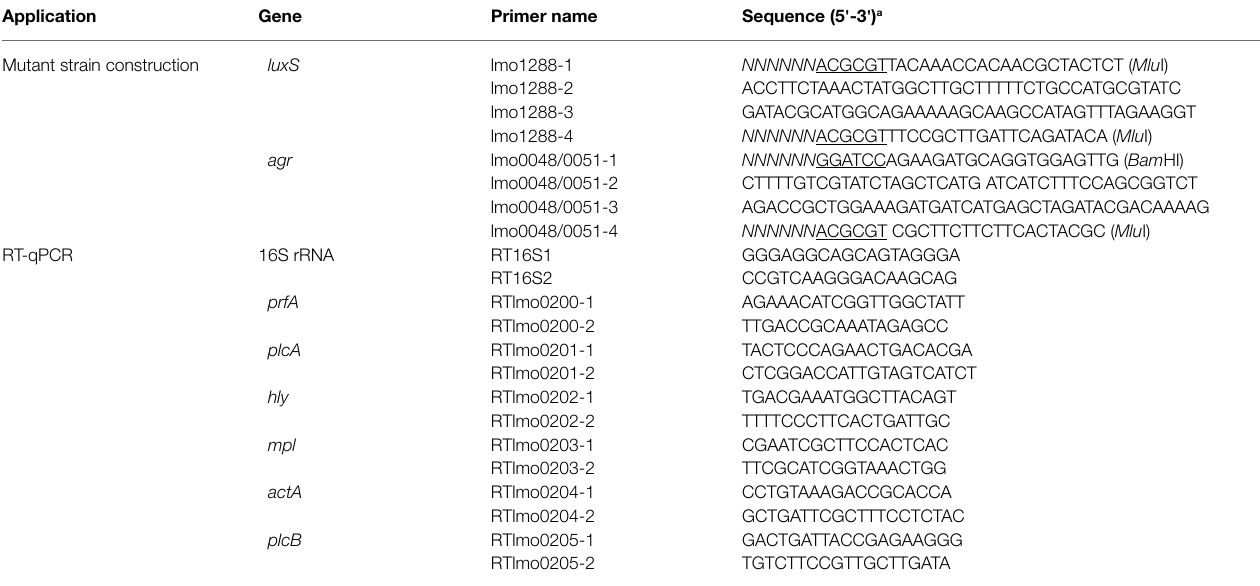
TABLE 2 | Primers used in this